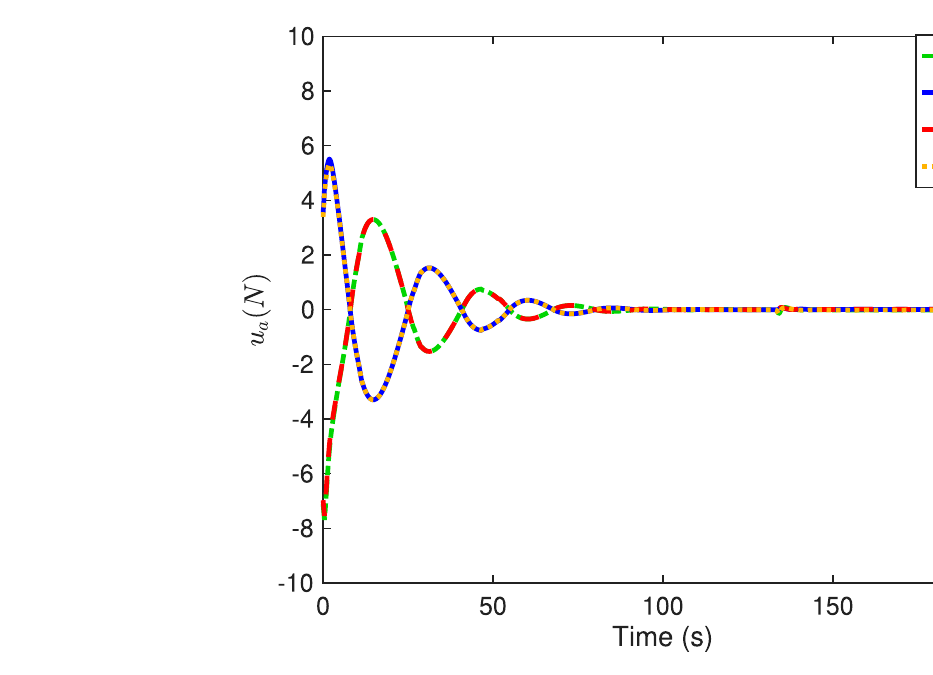
FIGURE 6 Thruster forces of #1-#4 in the STC.